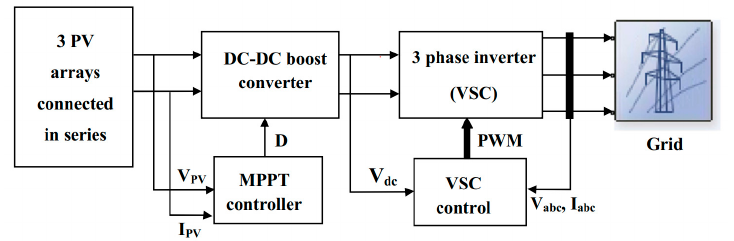
4 of 14 Figure 1. Block diagram of the grid connected PV system. Impact of Irradiance and Shading on the PV System Figure 2a illustrates the e ff ect of uniform solar radiation on the P-V curves of the PV array. As the irradiance increases, the generated power also increases and vice versa [28]. There exists a single point, referred to as the MPP, where the power generated is at its maximum, and to operate the PV array at this point, the impedance of the PV and the